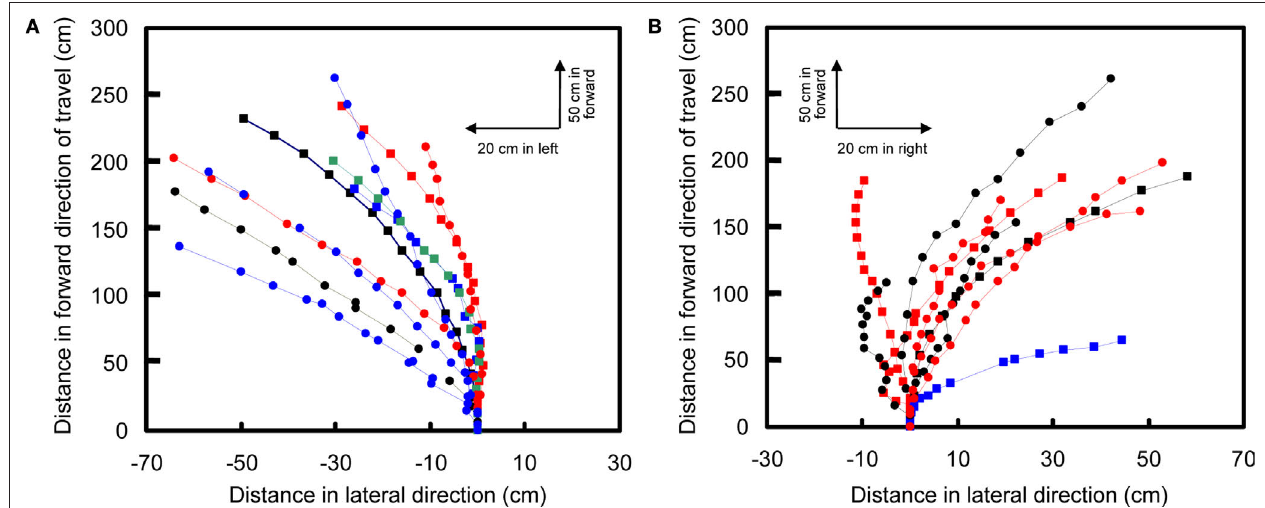
FIgure  | Turn control of free-flying Mecynorrhina torquata beetle. Pulse trains at 100 Hz and 1.3 V positive potential to the left or right basalar muscle triggered turns. Ten flight paths elicited by a 0.5-s continuous stimulus to (A) right or (B) left basalar flight muscle. Each flight path is obtained after the three-dimensional digitized flight path is projected on the XY-plane (see text for